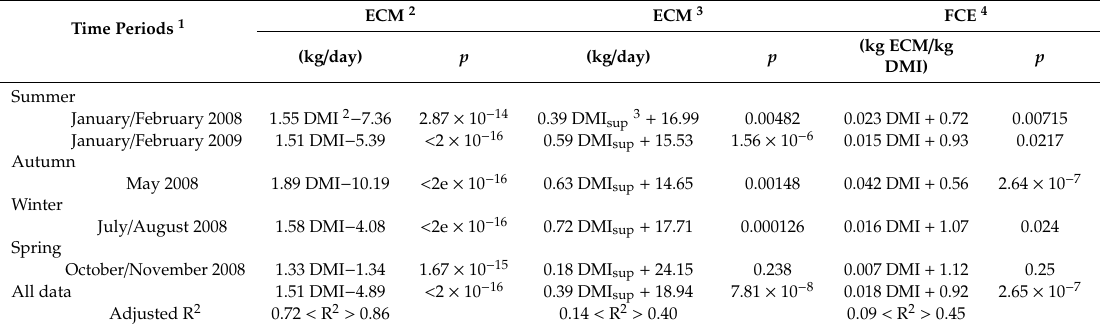
Table 5. Linear regression relationships and p value for relationships between per cow energy